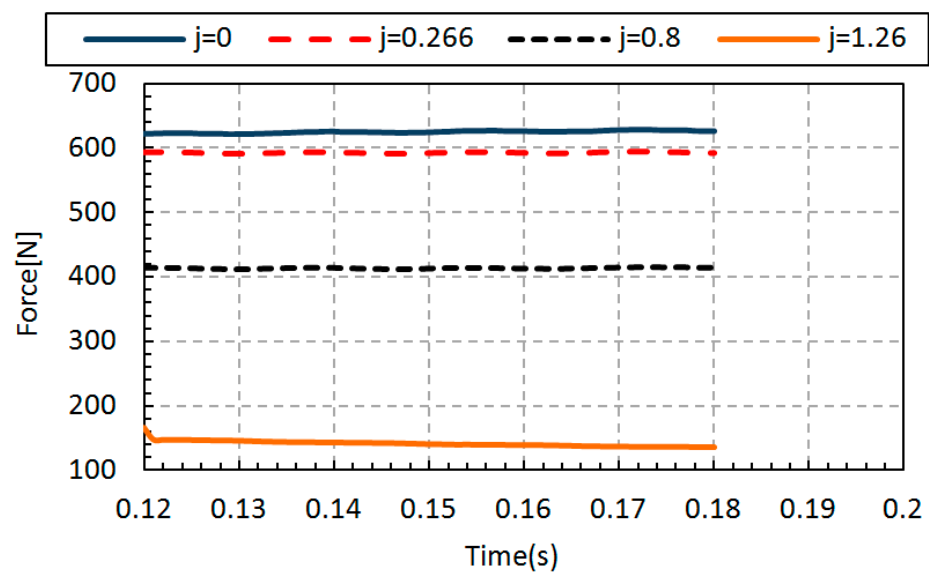
Figure 6. Integral forces act on the propeller at the different advanced coefficients.